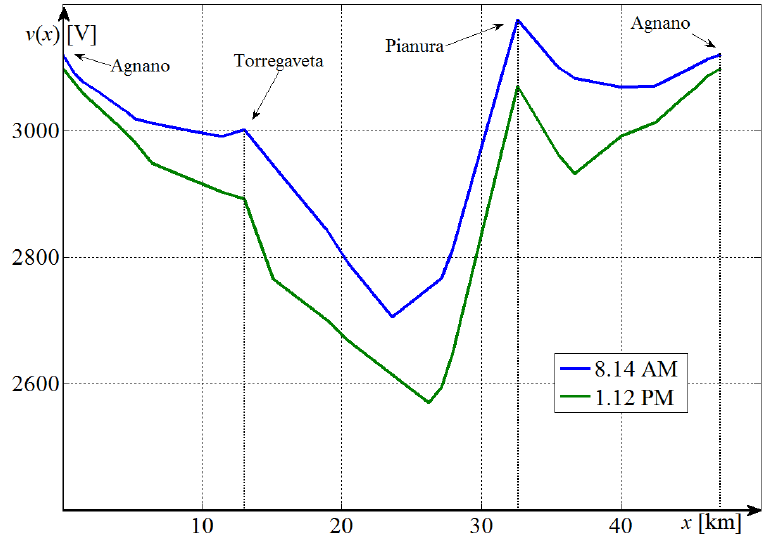
Figure 8. Contact line voltage for the two situations